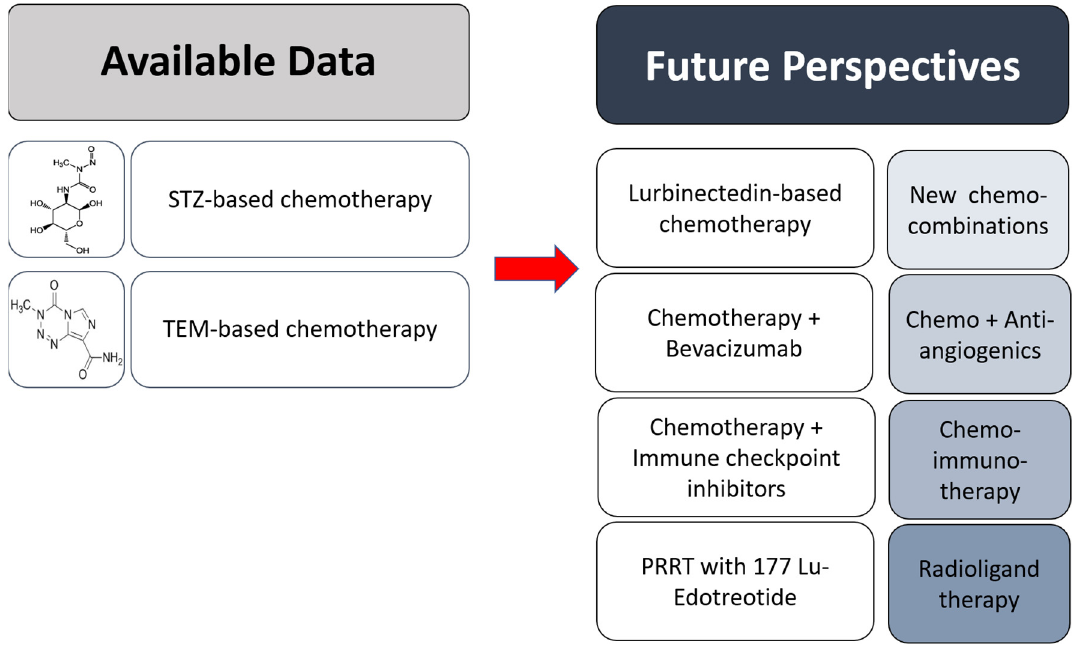
Figure 1. Current evidence and future perspectives for the medical treatment of advanced NET G3. Chemo: Chemotherapy, TEM: Temozolomide, PRRT: Peptide Receptor Radionuclide Therapy, STZ: Streptozocin.